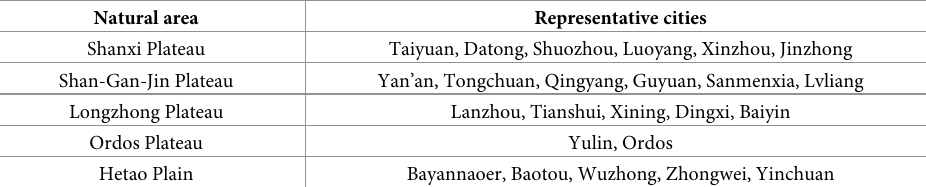
Table 1. Classification of natural areas in the Loess